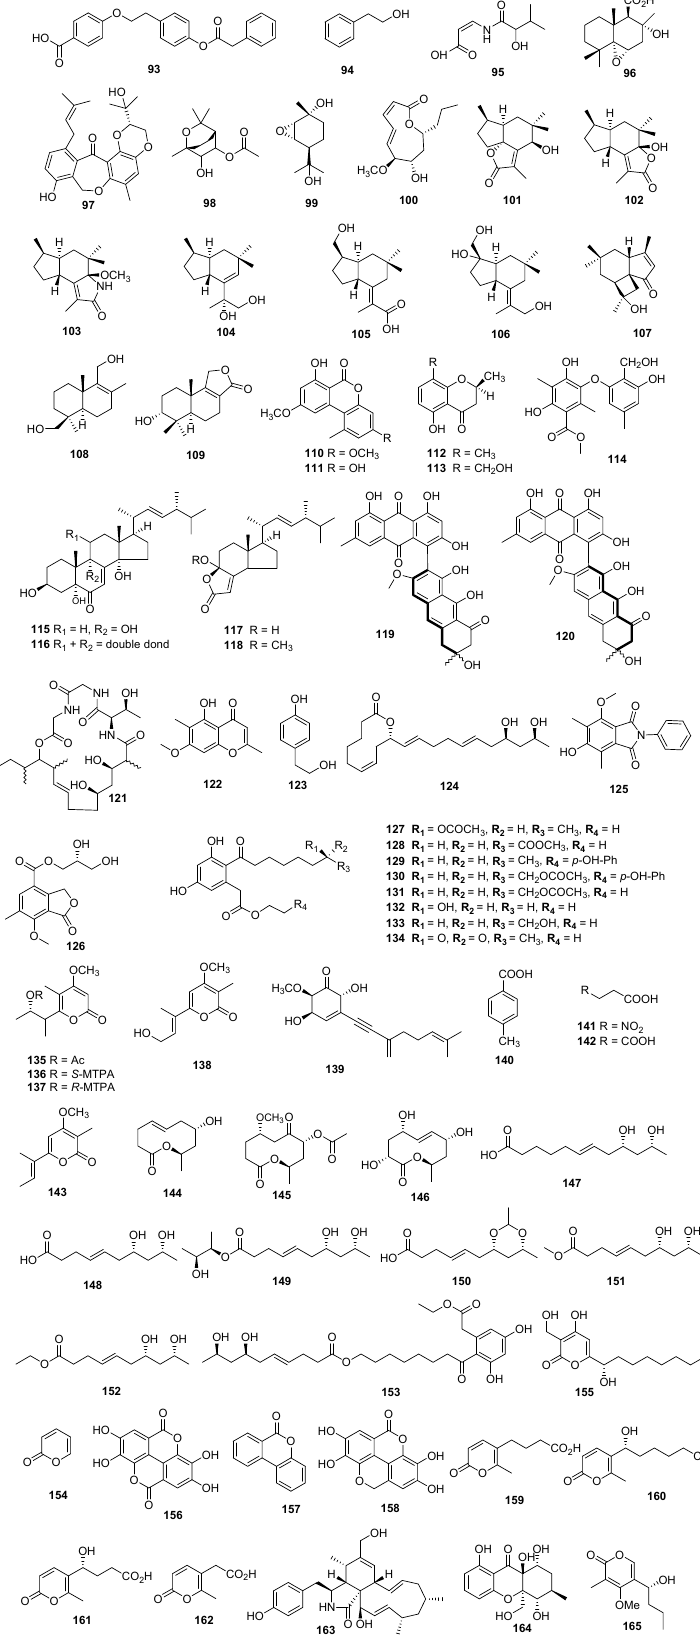
Figure 5. Chemical structures of compounds 93 – 165 of terrestrial